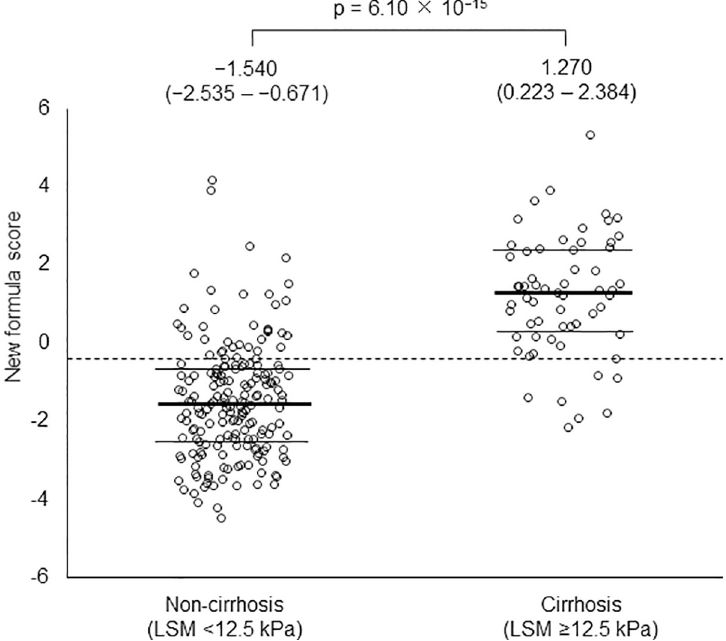
Fig 4. Comparison of novel formula scores between LSM � 12.5 kPa (cirrhosis) and LSM < 12.5 kPa (non- cirrhosis) in the validation set. The bold lines through the middle of each plot represent the median, while thin lines denote interquartile ranges. A dotted line denotes the optimal cutoff value ( − 0.381) to discriminate between patients with and without cirrhosis.